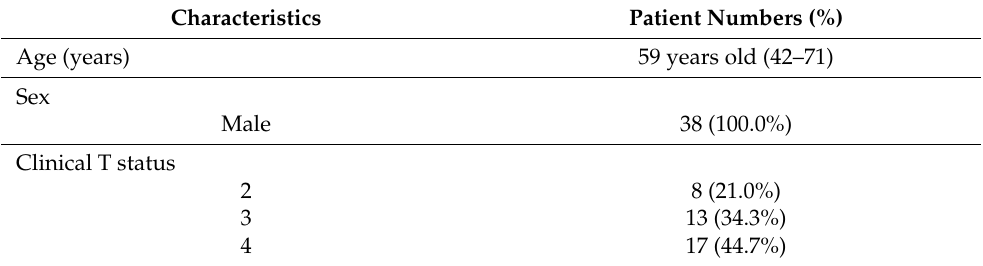
Table 4. Characteristics of 38 ESCC patients who received pembrolizumab/nivolumab as second-line or later